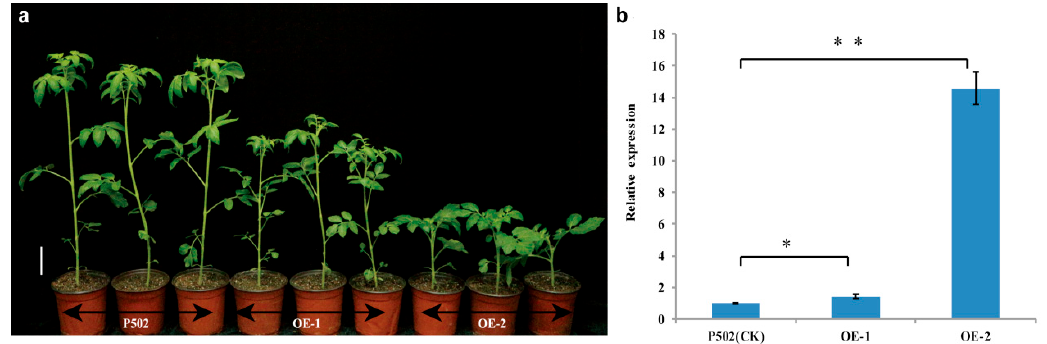
Figure 6. Overexpression of wild-type EI gene reduced the internode length of mutant P502. ( a ) Phenotype of P502 (CK) and T 1 transgenic plants (OE-1 and OE-2) at 40-day-old seedlings. ( b ) Expression level of EI in T 1 lines (OE-1 and OE-2). Total RNA was isolated from internode of P502 and transgenic T 1 plants at 40-day-old seedlings. Data represent mean ± SD based on three independent biological and three technical experiments. Scale bar is 5 cm in ( a ). Statistical significances were calculated based on two-tailed, two-sample Student’s t -test at * p < 0.05 and ** p < 0.01.